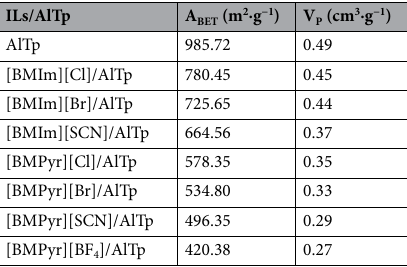
Table 2. CO 2 adsorption capacity Q e ( mg CO 2 . g − Standard uncertainties are u ( Q e ) = 0.001, u( T ) = 0.05 K, and u ( p ) =